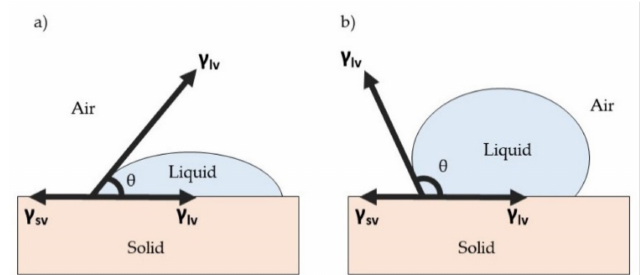
Figure 9. Contact angle of the liquid droplet between ( a ) hydrophilic surface and ( b ) hydrophobic surface.